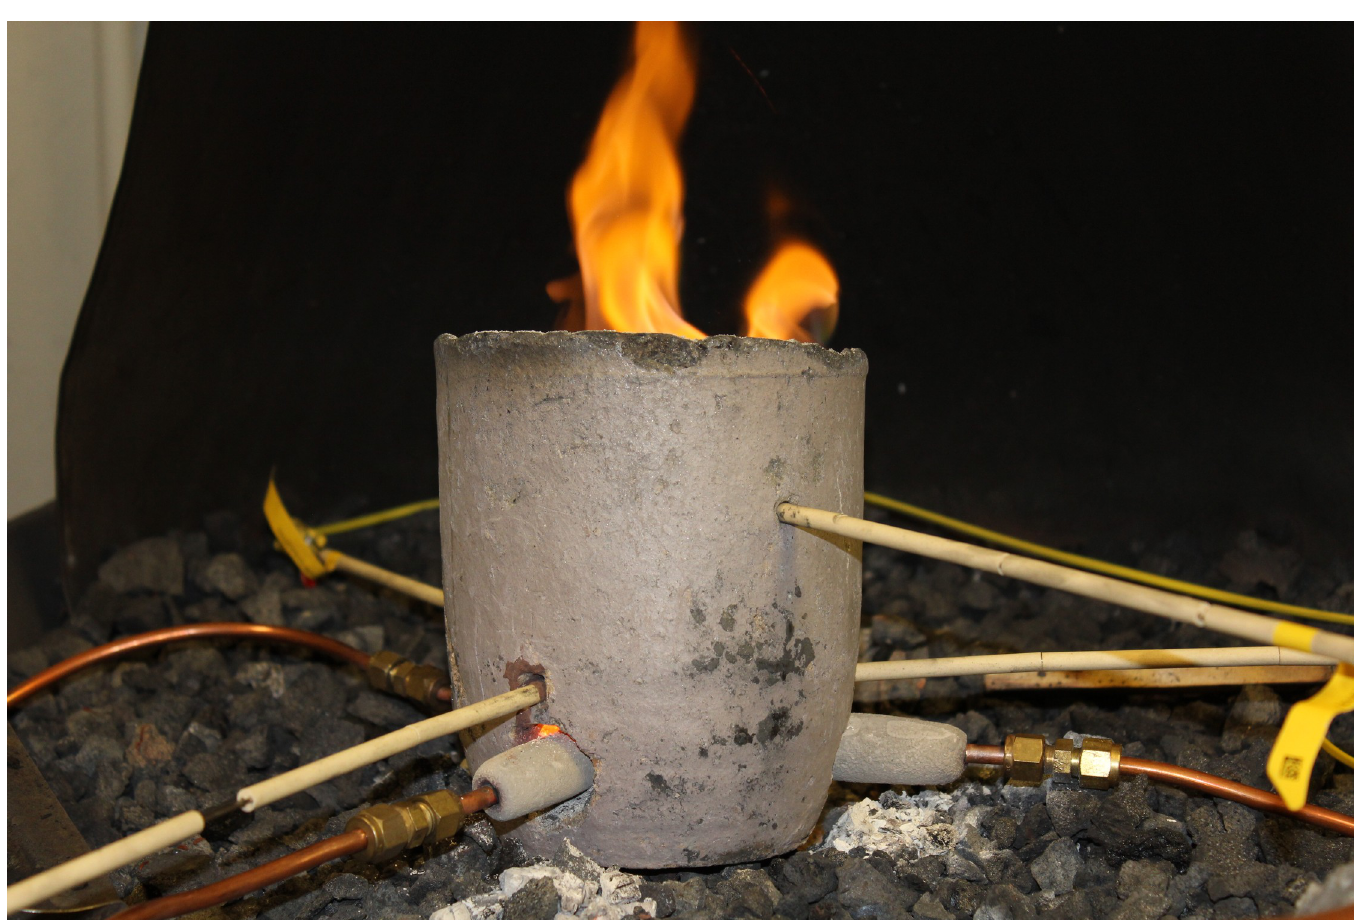
Fig 4. Experimental tuy è res and furnace. Experimental tuy è re and furnace setup, at the MIT metallurgy forge in the Department of Materials Science and Engineering. Photograph by Elizabeth Paris.